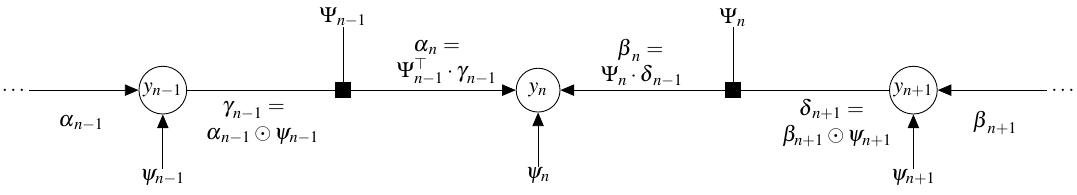
Figure 2. In this figure we show how marginal inference is performed over node y n with Conditional Random Field (CRF) models, where we have related the theoretical foundations of CRFs described in this section to a graphical representation of a short sequence. Note, the CRF is an undirected graphical model, and the arrows shown in this image indicate the direction of the passed messages when performing inference on y n